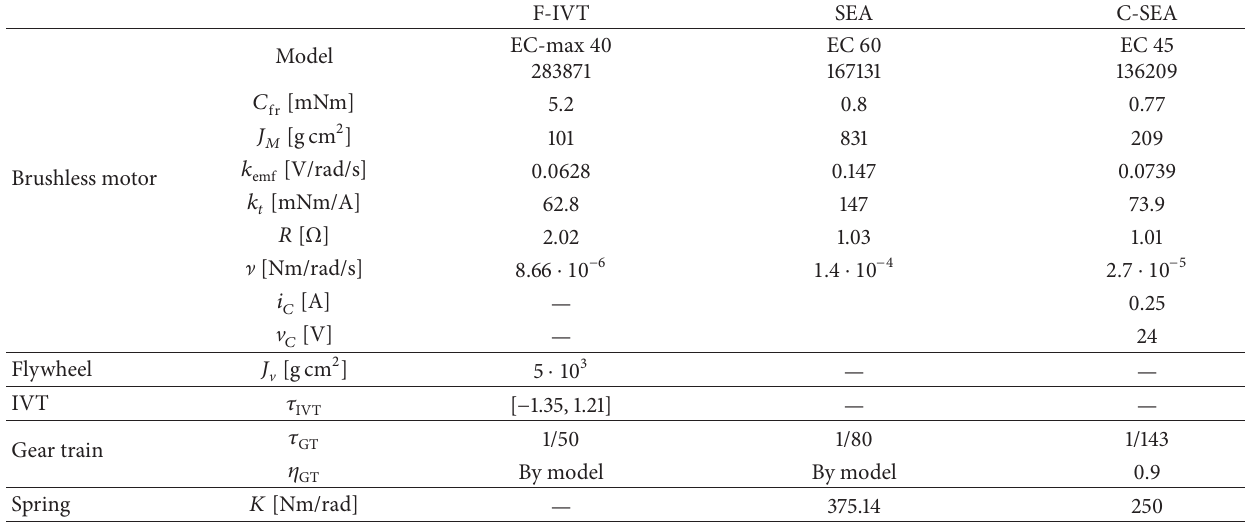
Table 1: Model parameters of the actuators F-IVT, SEA, and C-SEA. The motor damping parameters and the Coulomb friction torque are not provided by data sheet, but they were estimated following the guidelines given by